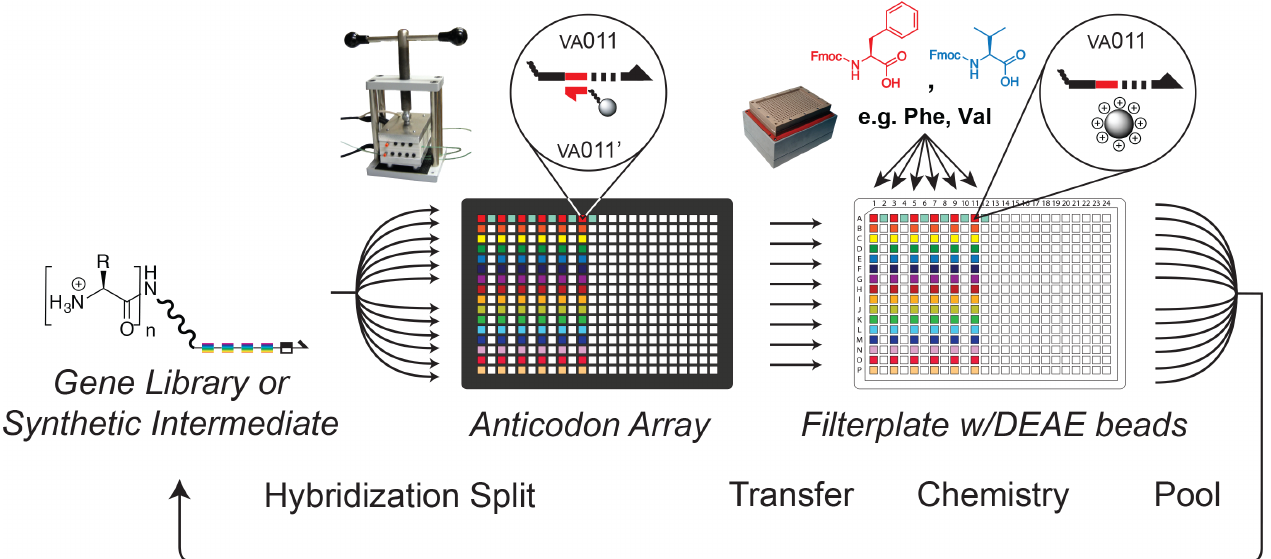
Fig 3. DNA-programmed combinatorial library synthesis. For each of four synthetic steps, the DNA genes were split into 384 sub-pools by hybridization of the codons in one of the coding regions to a spatially arrayed set of complementary oligonucleotides. The DNA genes were then transferred in a one-to-one fashion from the hybridization array into a 384-well filter plate loaded with DEAE-Sepharose resin. The DEAE resin acted as a solid support that retained the DNA genes during chemical reactions. One of seventeen different Fmoc-protected amino acids (dependent on the sub-pool position within the 384-well plate) was then coupled to the growing peptide chain linked to the DNA. After the chemical step, the genes were pooled, and the split-pool process was repeated until all of the coding regions had been chemically translated.